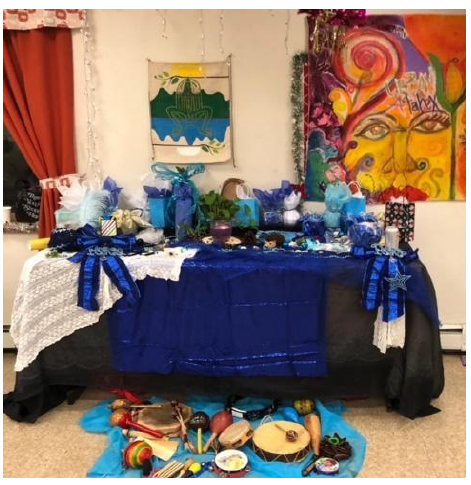
Figure 7. The community altar at our Winter Solstice Tea Party at Casabe Houses. 21 December